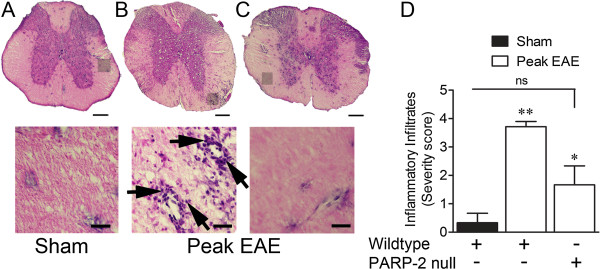
Poly(ADP-ribose) polymerase 2 (PARP-2) deletion reduces spinal inflammation. (A-C) Peak experimental autoimmune encephalomyelitis (EAE) disease ((B) wild-type and (C) PARP-2 null) and sham control (A) spinal cords were subjected to hematoxylin and eosin staining. Wild-type EAE cords have substantial cellular infiltration to the parenchyma (B) while the sham control (A) and PARP-2 EAE cords (C) have minimal visible infiltration. Results are quantified in (D). Arrows point to perivascular foci of inflammatory infiltration. Scale bars are 200 μm (top row, (A-C)) and 25 μm (bottom row, (A-C)); bottom row in (A-C) represents magnification of top row framed areas. Values are mean ± SEM (n = 3 to 7). Results in (D) were analyzed using Kruskal-Wallis non-parametric analysis of variance (ANOVA) with Dunn’s multiple comparisons test. **P <0.01 compared to sham; *P <0.05 compared to wild-type EAE group; not significant = P >0.05.